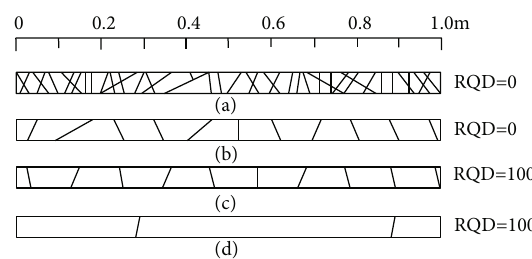
Figure 7: Examples of RQD values for various joint densities along drill cores